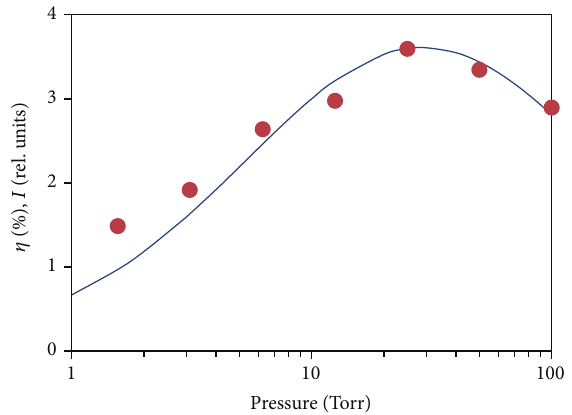
Figure 2: Dependence of radiation intensity (points) and lumines- cence efficiency (calculation by formula (2)) for 𝜆 = 337.1 nm on nitrogen pressure in Ar (1.5 Atm) + N 2 mixture.